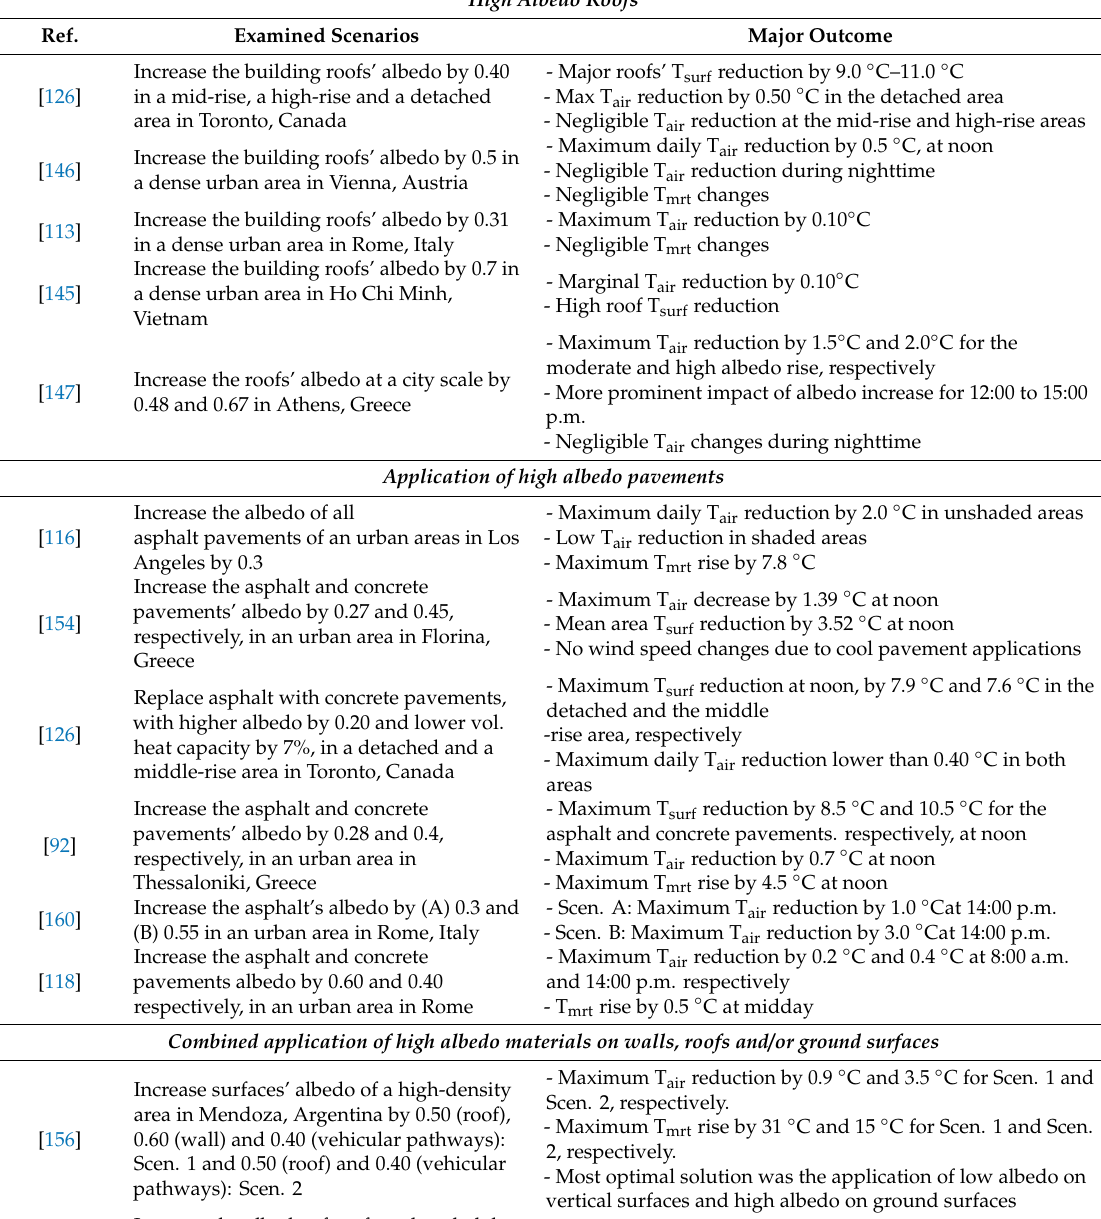
Table 4. Summary of previous studies, assessing the cooling potential of high albedo roofs, pavements and combined applications. T air and T mrt simulation results refer to the pedestrians’ heights (i.e., 1.5–2.0m from the ground